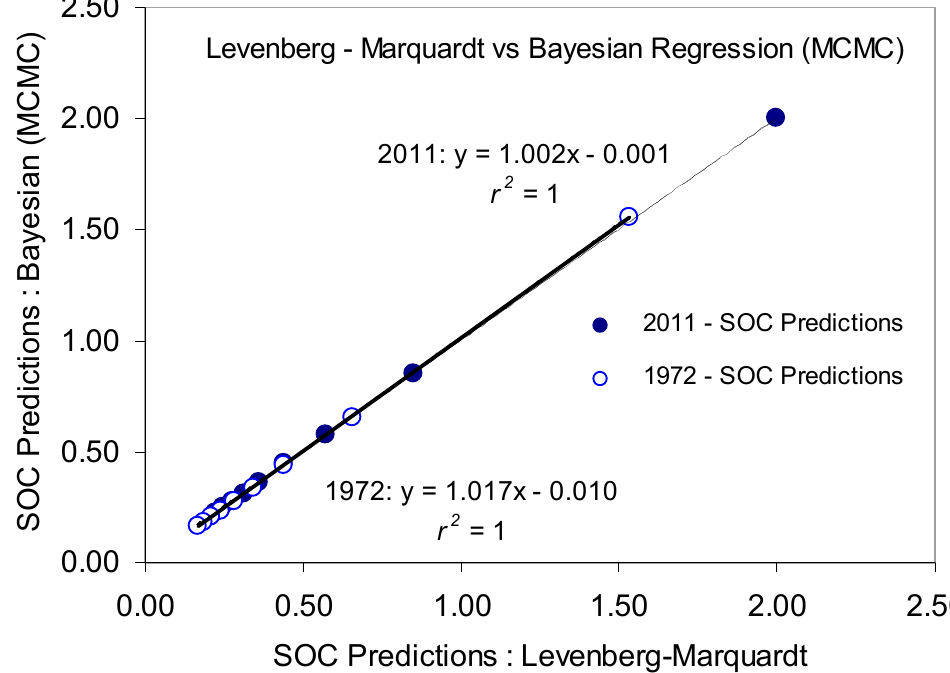
Figure 2. Levenberg–Marquardt error-minimisation regression model vs. Bayesian regression (MCMC) shows good agreement in SOC model predictions using the power law function. Table 1. Comparison of Frequentist and Bayesian regression results for parameter uncertainty for SOC depth profile (based on parameters θ 1 and θ 2 in the Power Law